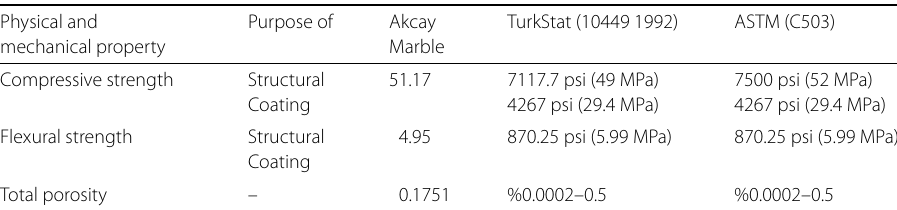
Table 12 Required values for Turkstat and ASTM standards classified according to the purpose of use of the marble